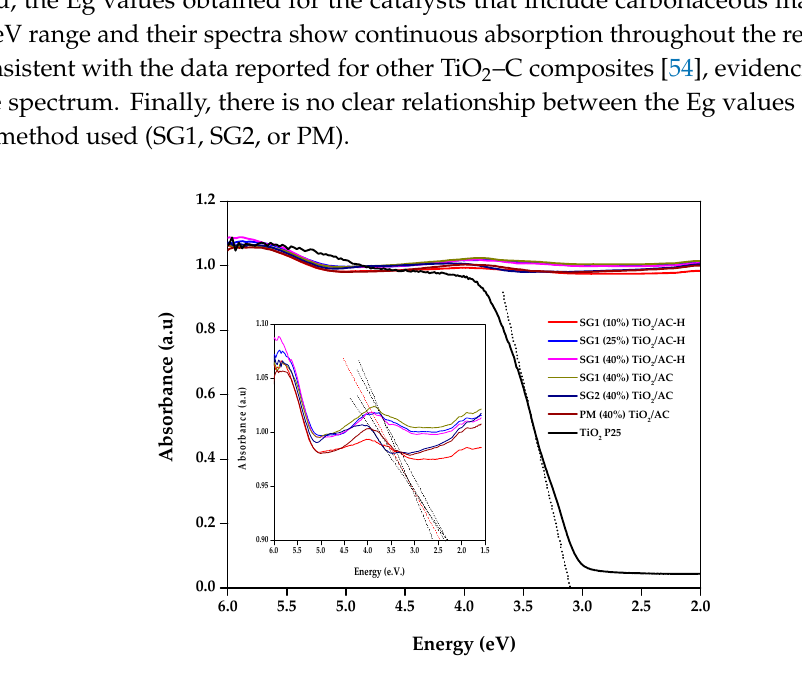
Figure 5. Diffuse reflectance UV-Vis spectra of the different catalysts used in the present study. Figure 5. Di ff use reflectance UV-Vis spectra of the di ff erent catalysts used in the present